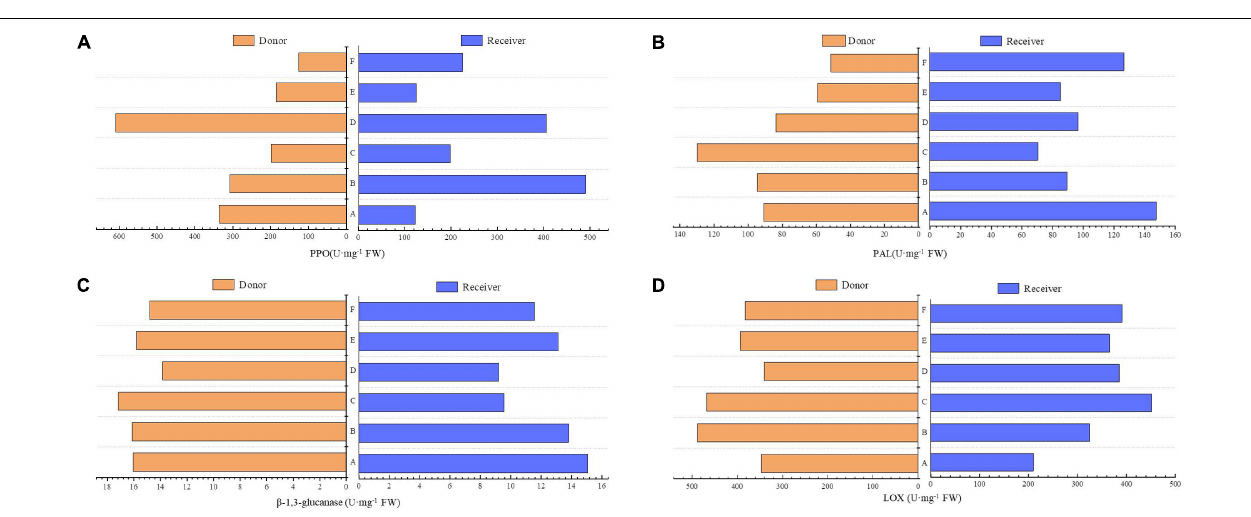
FIGURE 5 | Effects of AMF on enzymes of donor and receiver plants between different treatments. Data are mean ± SD (n =